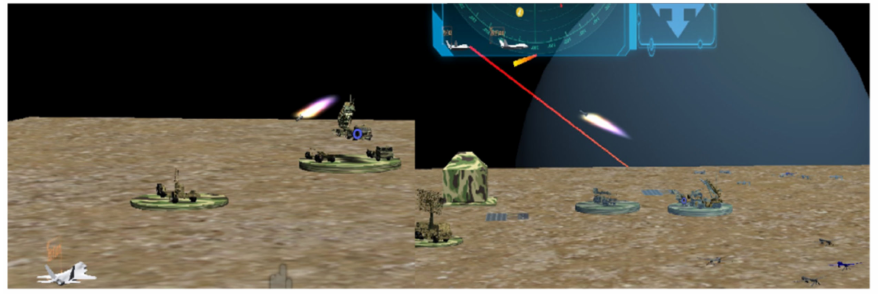
Figure 8. Strike interception diagram.